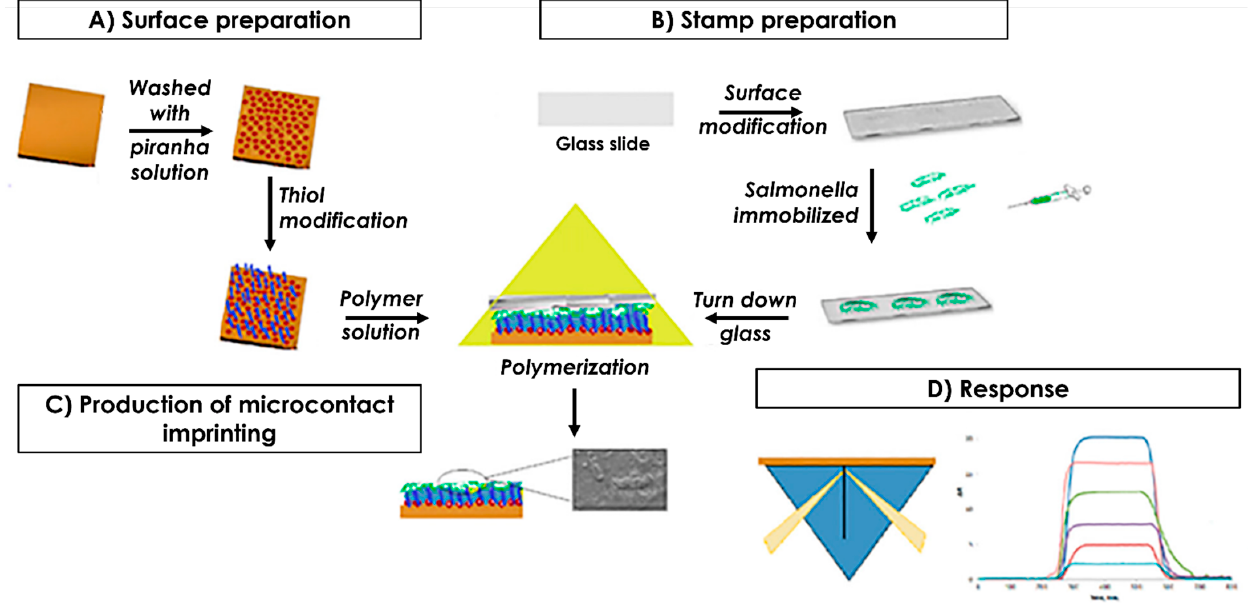
Figure 4. Scheme of the microcontact imprinting of S. paratyphi onto SPR chips. ( A ) preparation and modification of the SPR chip surface; ( B ) imprinting of S. paratyphi on a glass slide; ( C ) realization of the microcontact imprinting; ( D ) response of the SPR sensor. (Reproduced with permission from [49], open access Creative Common CC licensed 4.0, MDPI).